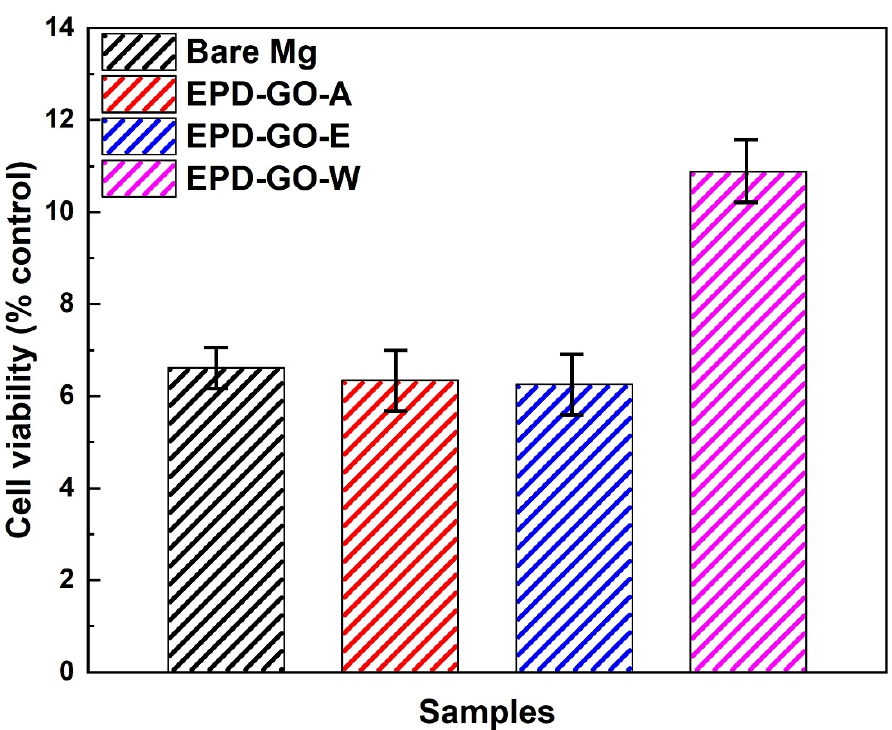
Figure 11. Percentage proliferation of MC3T3-E1 osteoblast cells lines cultured in media for 3 days with bare and EPD-GO-coated Mg